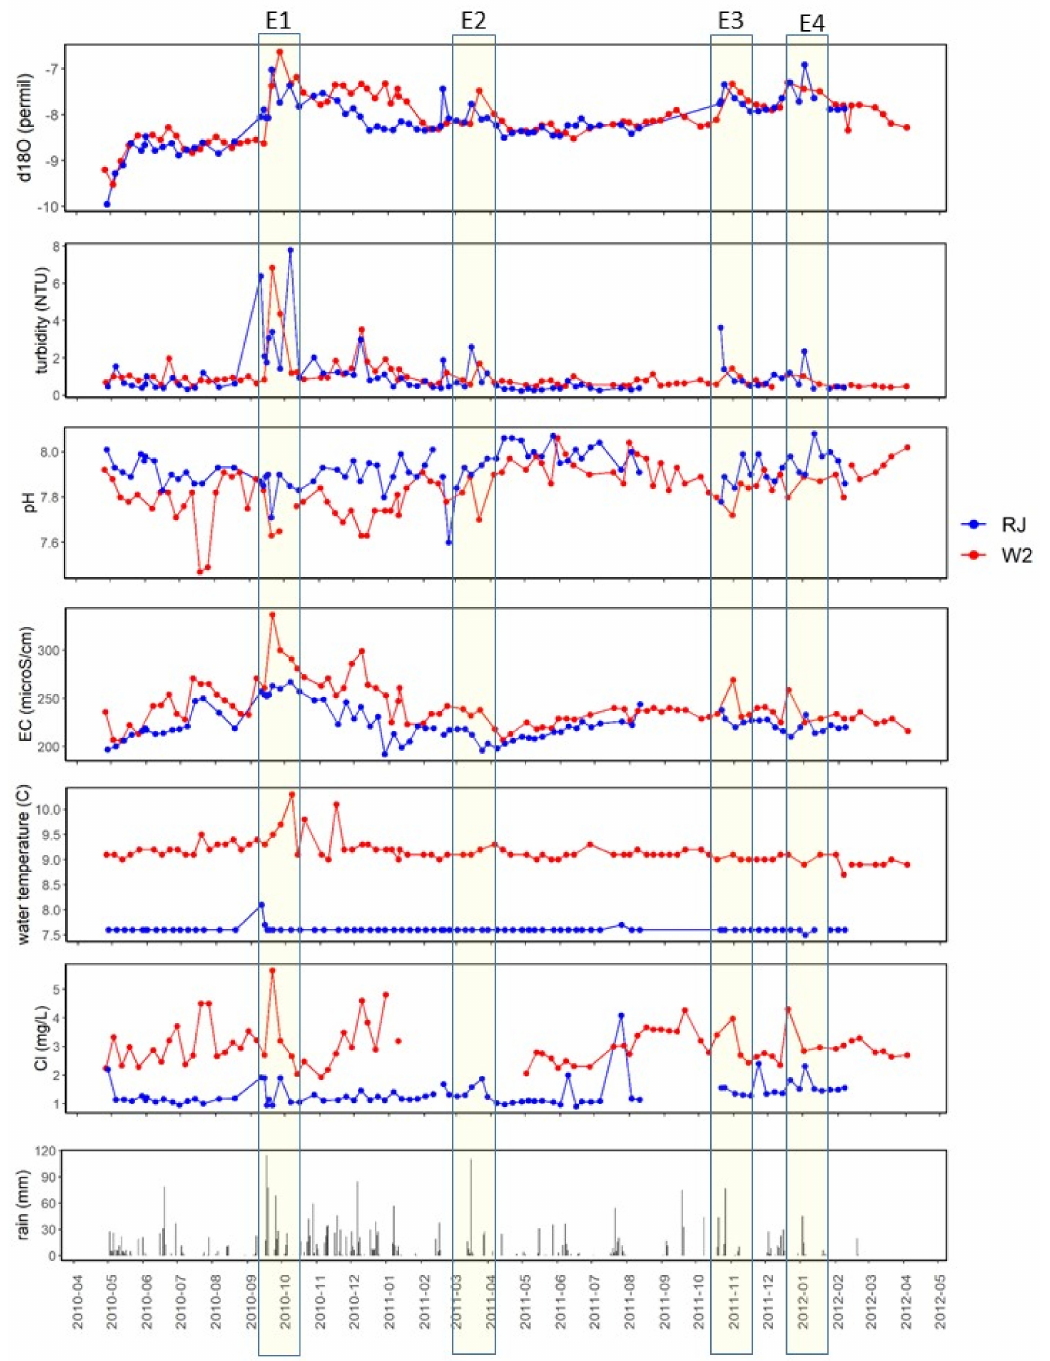
Figure 9. Time series of δ 18 O, turbidity, pH, electrical conductivity, temperature, and Cl content of Martinš´cica well 2 (W2) and Rjeˇcina Spring (RJ) against daily rain quantities at CMHS meteorological station Kukuljanovo. E1–E4—isolated events in which the presence of newly infiltrated precipitation in the system was recognized. The second event (E2) was identified in March 2011 when the δ 18 O values of the monthly rain were: − 5.06‰ KUK, − 5.14‰ SKAL, and − 6.59‰ PLAT. In October 2011 (E3), the δ 18 O-values of rain were − 8.11‰, − 7.65‰, and − 8.06‰ for KUK, SKAL, and PLAT, respectively. In January 2012 (E4) − 5.18‰ at KUK station, − 5.21‰ at SKAL, and − 7.0‰ at PLAT. Figures 9 and 10 show shifts in groundwater δ 18 O values toward less negative values for all three events